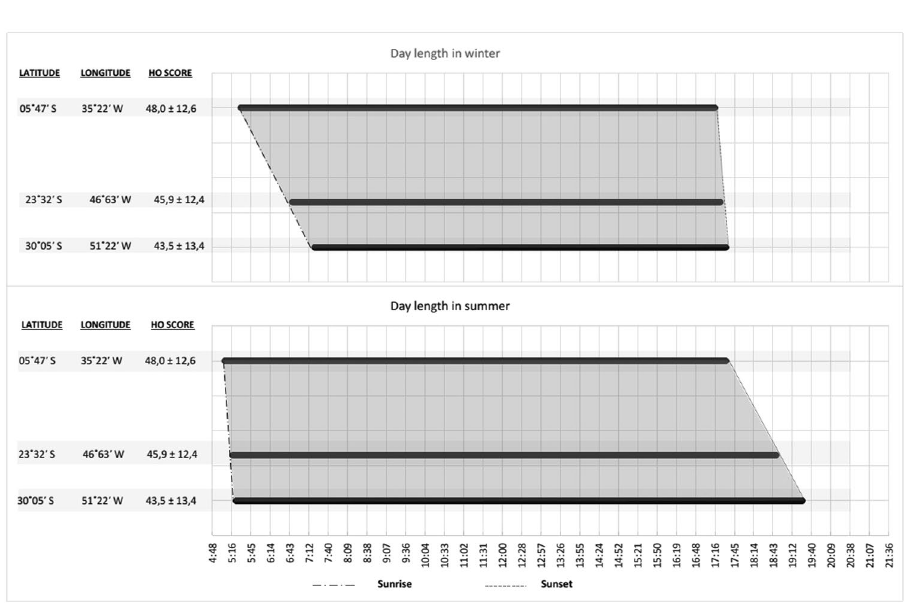
Figure 3. Sunrise, sunset and day length in the three cities depicted in summer and winter solstices. The grey area represents day length. During the summer, the increase in day length at higher latitudes is associated primarily with a delay of sunset (compared with low latitudes). During the winter, the decrease in day length at higher latitudes is associated primarily with a delay of